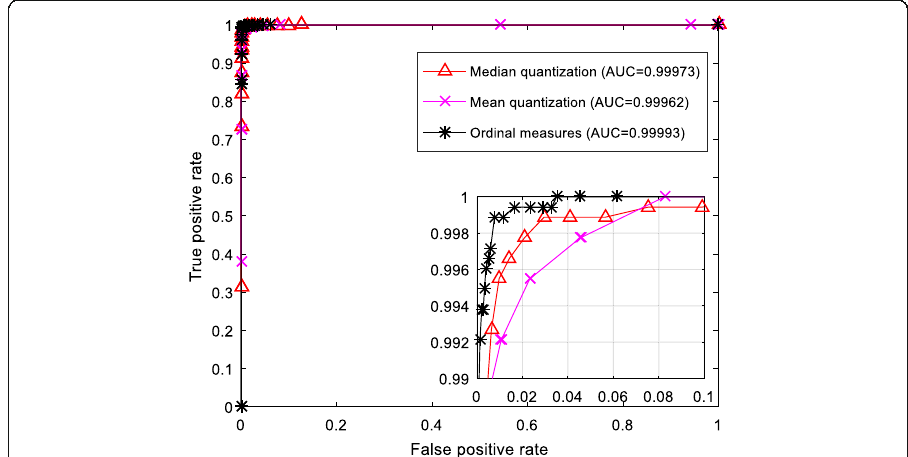
Fig. 9 ROC curves of different quantization